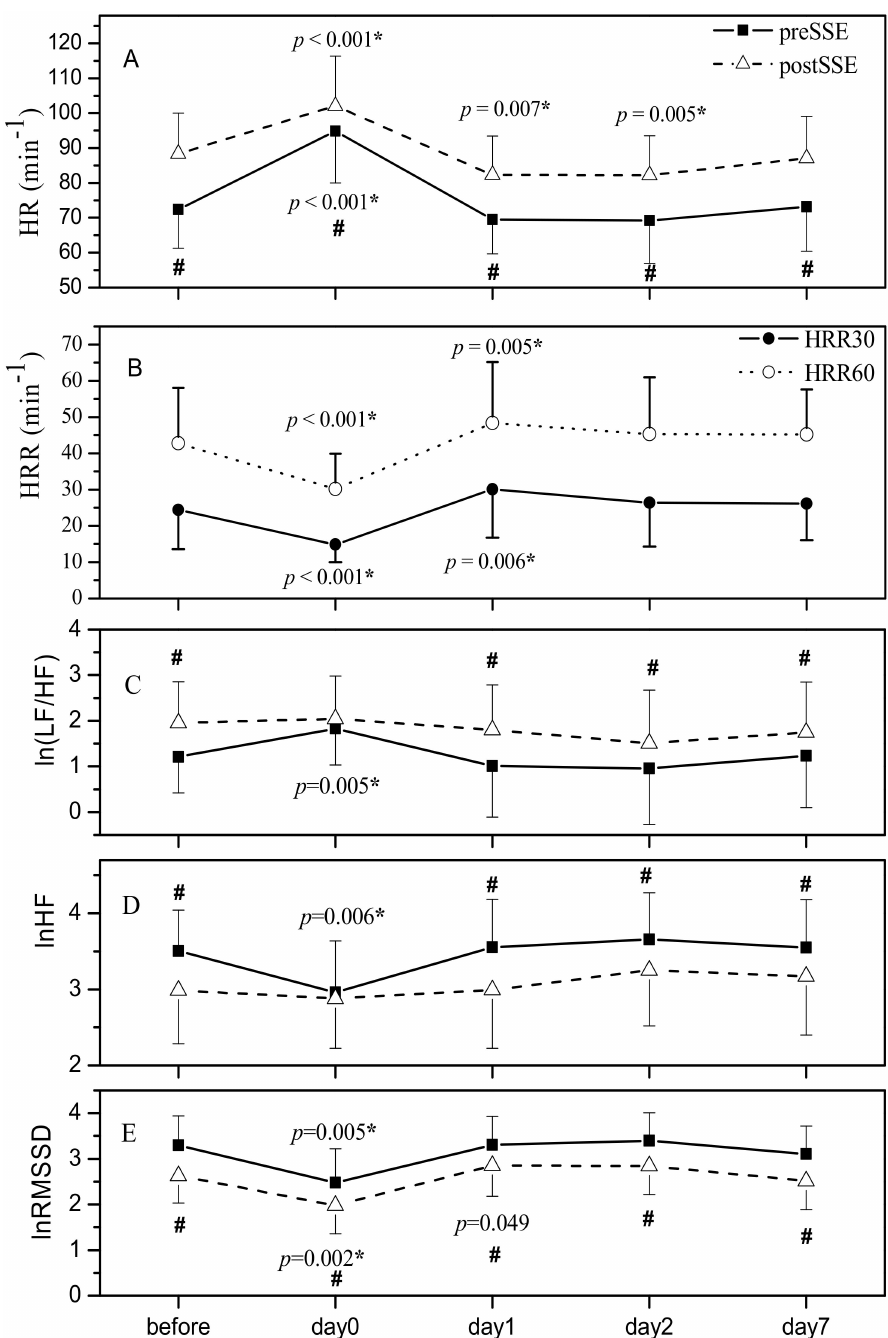
Figure 2. The time course of HR ( A ), HRR ( B ), ln(LF/HF) ( C ), lnHF ( D ), and lnRMSSD ( E ) measured preSSE and postSSE over all five measuring timepoints during experimental trial (before—before PE (baseline), day0—1 h after PE, day1—1 day after PE, day2—2 days after PE, day7—one week after PE). HR—heart rate; HRR30—heart rate recovery in 30 s; HRR60—heart rate recovery in 60 s; ln(LF/HF)—ln transform of the ratio of low-frequency power to high-frequency power in frequency domain heart rate variability; lnHF—ln transform of high frequency power of frequency domaine heart rate variability measured in normalized units; lnRMSSD—ln transform of root mean square of successive interval differences of time domaine heart rate variability; PE—prolonged exertion; SSE—short-lasting submaximal exercise. Values are represented as mean ± standard deviation. *—statistically significant compared to baseline (before), p —corresponding p value; #—statistically significant difference postSSE versus